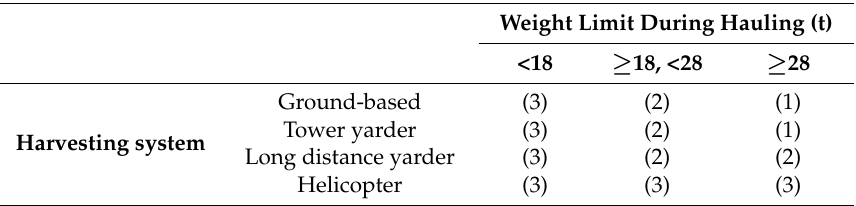
Table 2. The suitability of an area for economical timber production depends upon the choice of harvesting system (4 options shown) as well as the weight limit during hauling (3 options shown), and can be described according to quality classes: (1) Fulfills best practice requirements; (2) limited suitability for efficient management; or (3) no efficient management possible (not